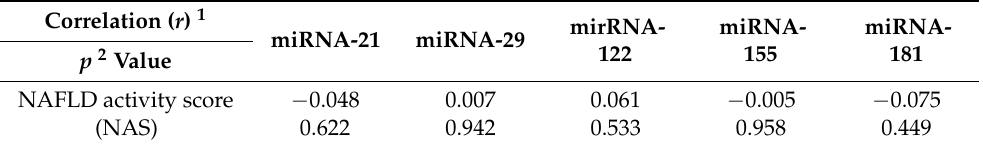
Table 6. Correlation between microRNAs and NAFLD activity score